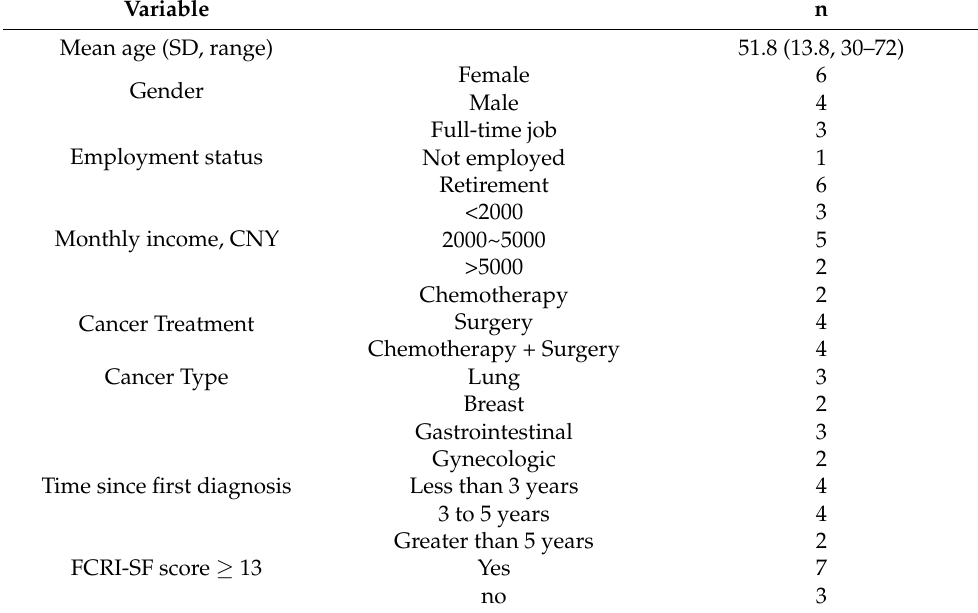
Table 1. Participant Demographics (n =